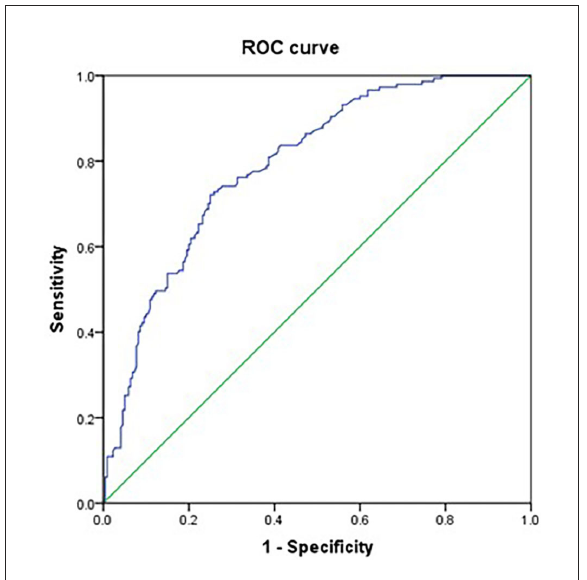
FIGURE1 ROC curves for the probability of decannulation at 6 months.